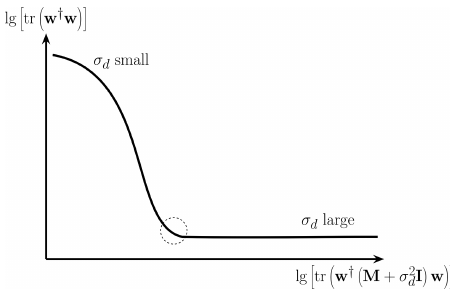
Figure 2. Sketch of the L curve for estimating the optimal diagonal loading parameter σ d . The optimal value is located in the vicinity of the L curve’s knee (dashed circle).